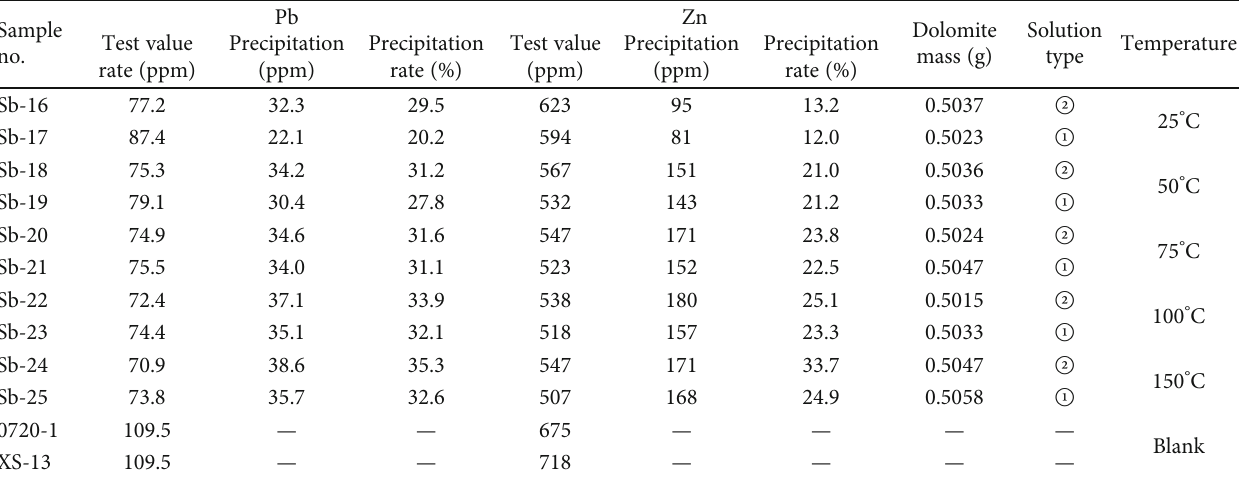
Table 5: Test results of the water-rock interaction experiment.